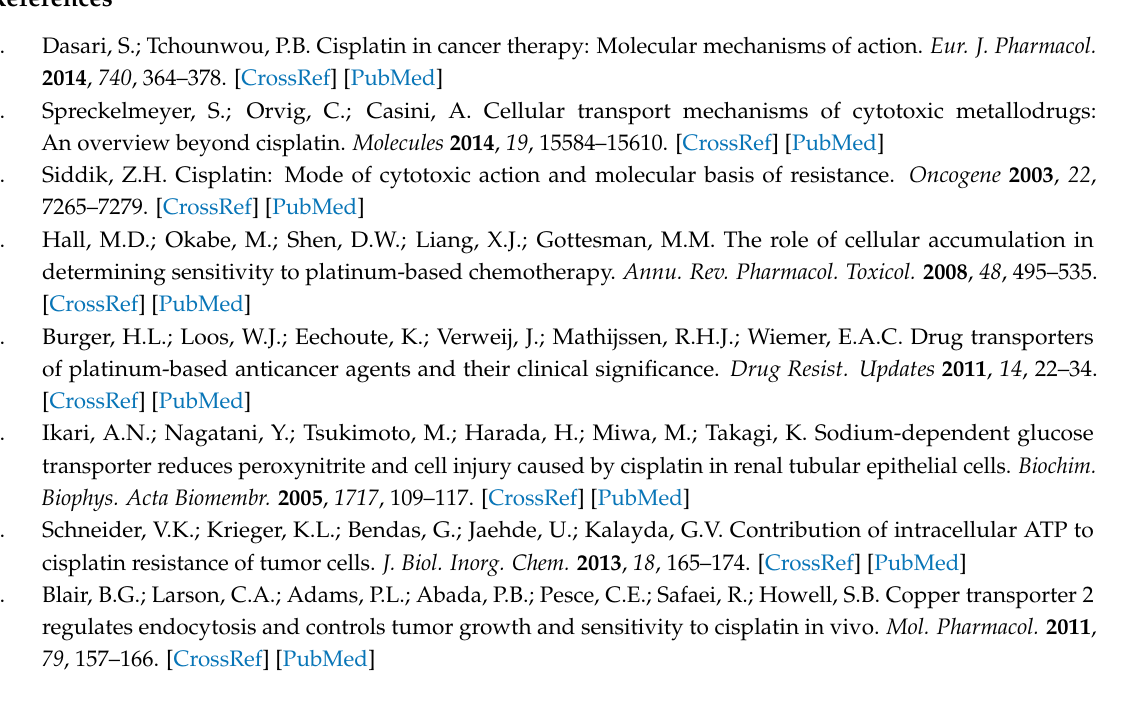
Figure S1: Late endocytic pathway in A431/A431 Pt and HeLa/HeLa Pt cell line, Figure S2: Expression of endocytic Rabs in chemosensitive and chemoresistant cell lines, Figure S3: Test of acquired chemoresistance of HeLa Pt by MTT assay; Table S1 : Sequences of primers and siRNA used in this